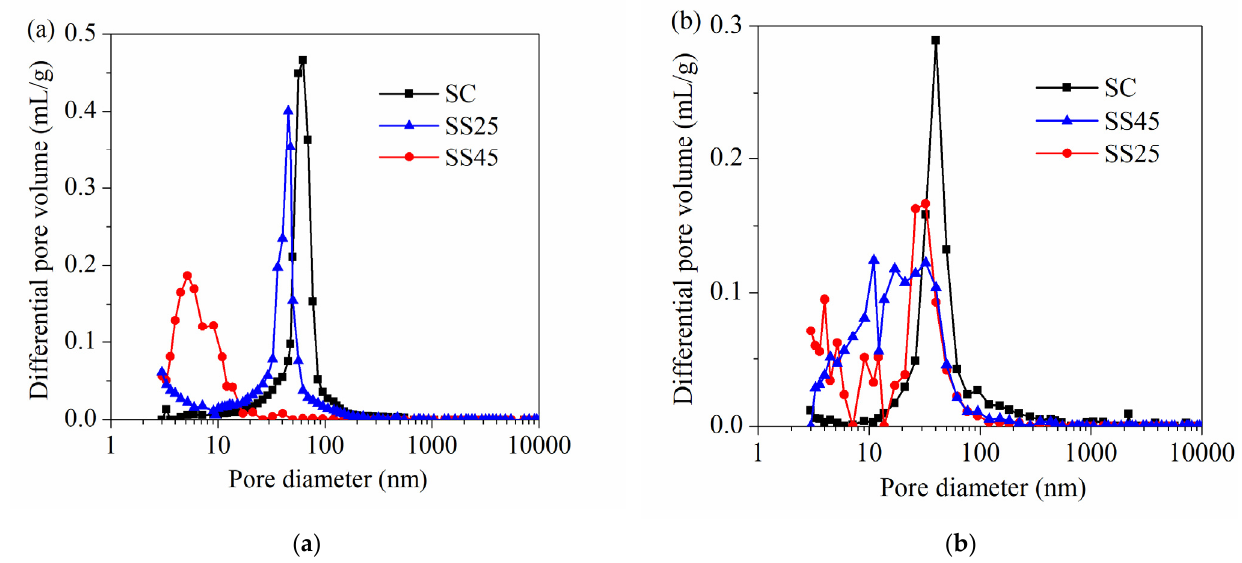
Figure 6. Differential pore volume of hardened pastes under standard curing conditions: ( a ) at 28 d; ( b ) at 90 d.